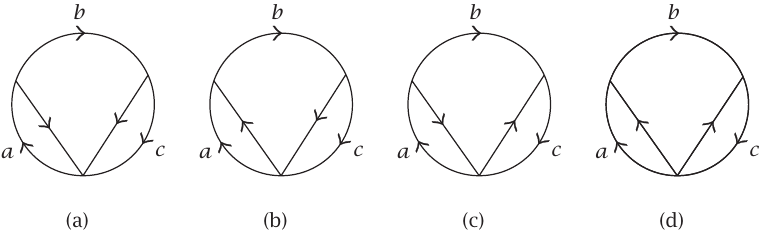
Figure 4.4 . Diagrams related to ζ(a,b,c) . The propagators without label are g ( 0 )